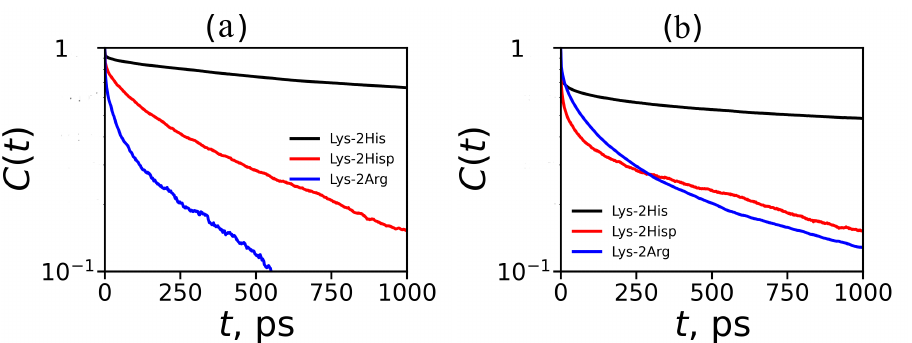
Figure 13. Autocorrelation functions C pairs ( t ) for imidazole–imidazole groups for Lys–2His and Lys–2Hisp (or guanidine–guanidine for Lys–2Arg) at T = 310 K ( a ) for pairs between neighboring groups and ( b ) for pairs between non-neighboring